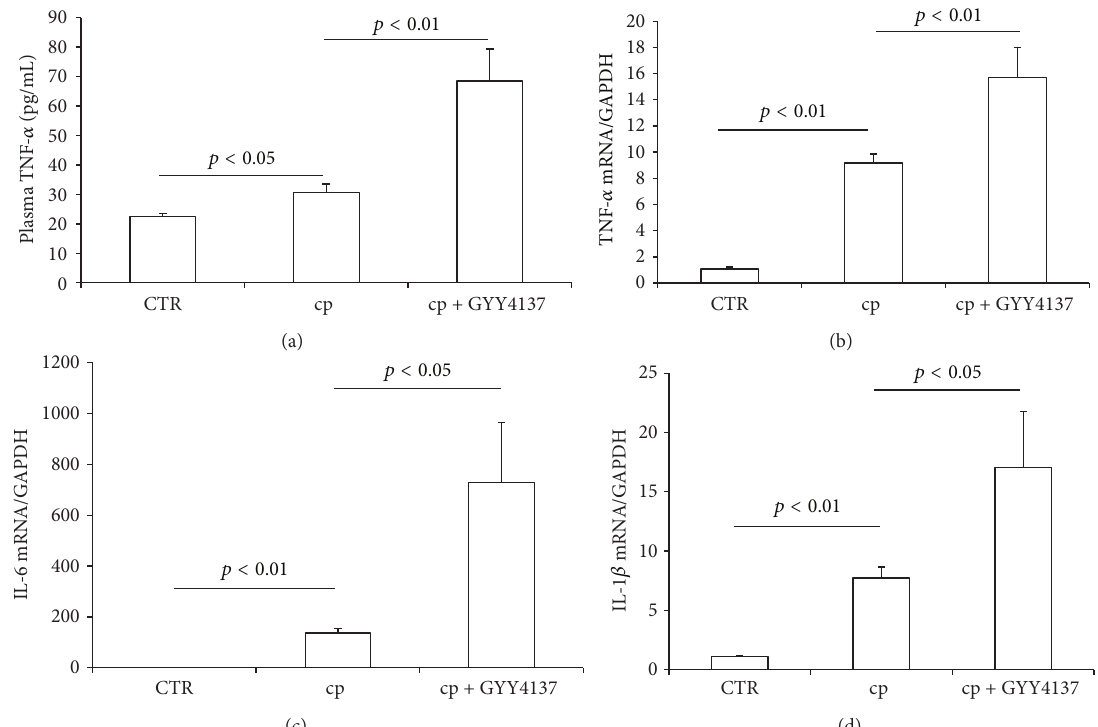
Figure 2: Effects of GYY4137 on cisplatin-induced inflammatory response. (a) Enzyme-linked immunosorbent assay analysis of circulating TNF- 𝛼 . (b) qRT-PCR analysis of renal TNF- 𝛼 mRNA expression. (c) qRT-PCR analysis of renal IL-6 mRNA expression. (d) qRT-PCR analysis of renal IL-1 𝛽 mRNA expression. CTR:control, 𝑛=5 ; cp: cisplatin, 𝑛=10 ; and cp + GYY4137: cisplatin + GYY4137, 𝑛 = 10 . Data are means ± SE.